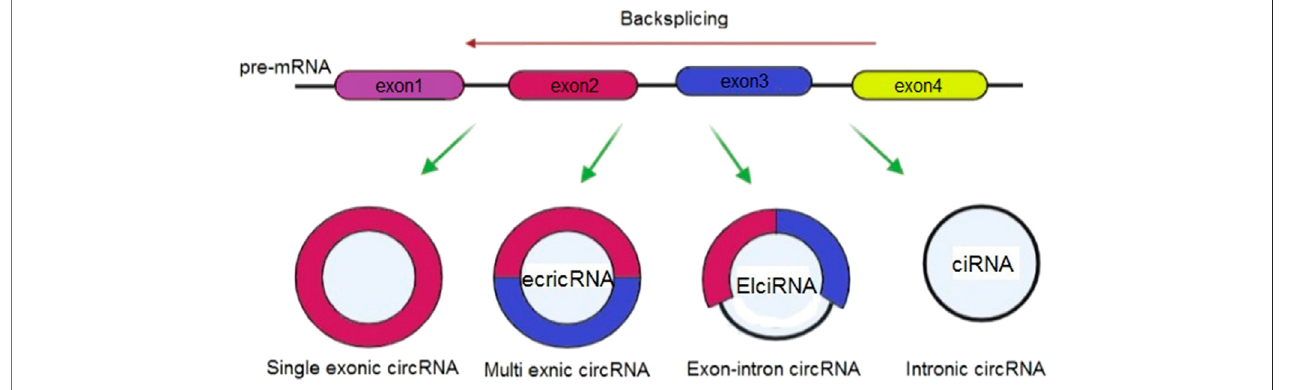
FIGURE 4 | Classi fi cation of circular